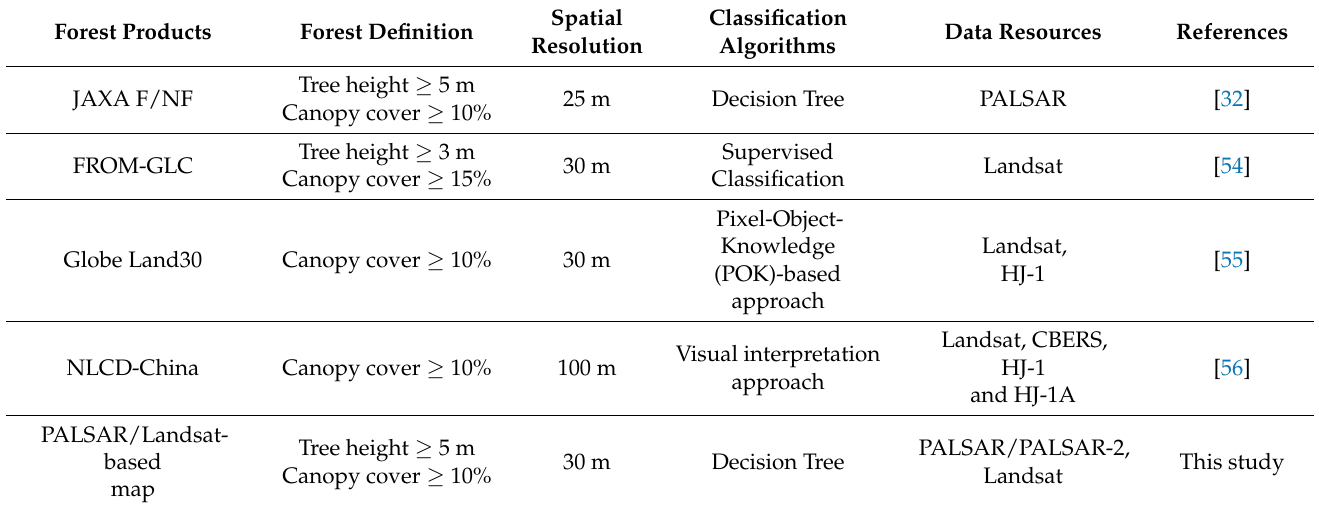
Table 1. Summary information of forest products in northern China in